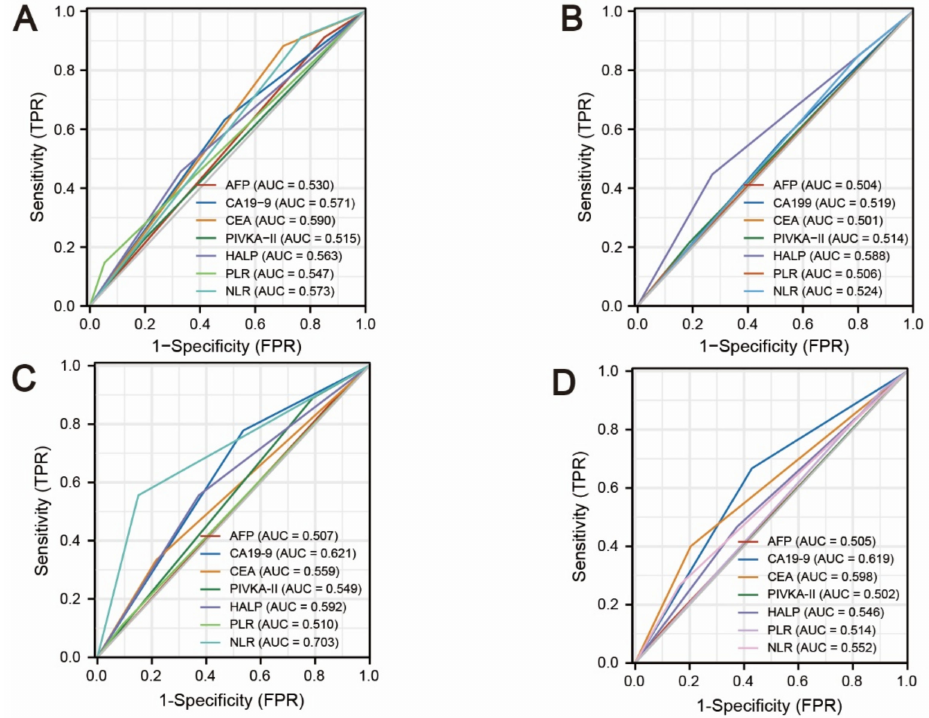
Figure 6. The area under the curve (AUC) for HALP, PLR, NLR, AFP, PIVKA-II, CEA, and CA19-9; ( A ) AUC of recurrence-free survival; ( B ) AUC of intrahepatic recurrence; ( C ) AUC of lymph node metastasis; and ( D ) AUC of distant metastasis